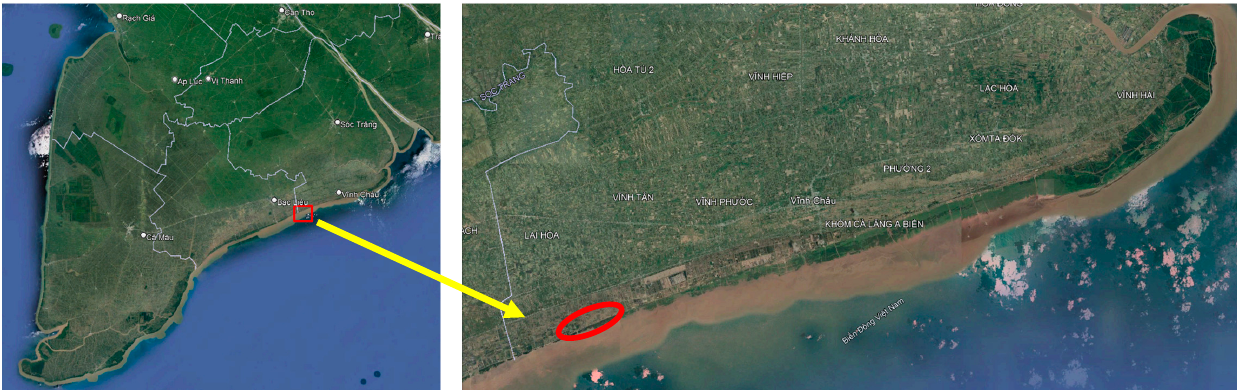
Figure 2. Location of expected construction (Google Earth).